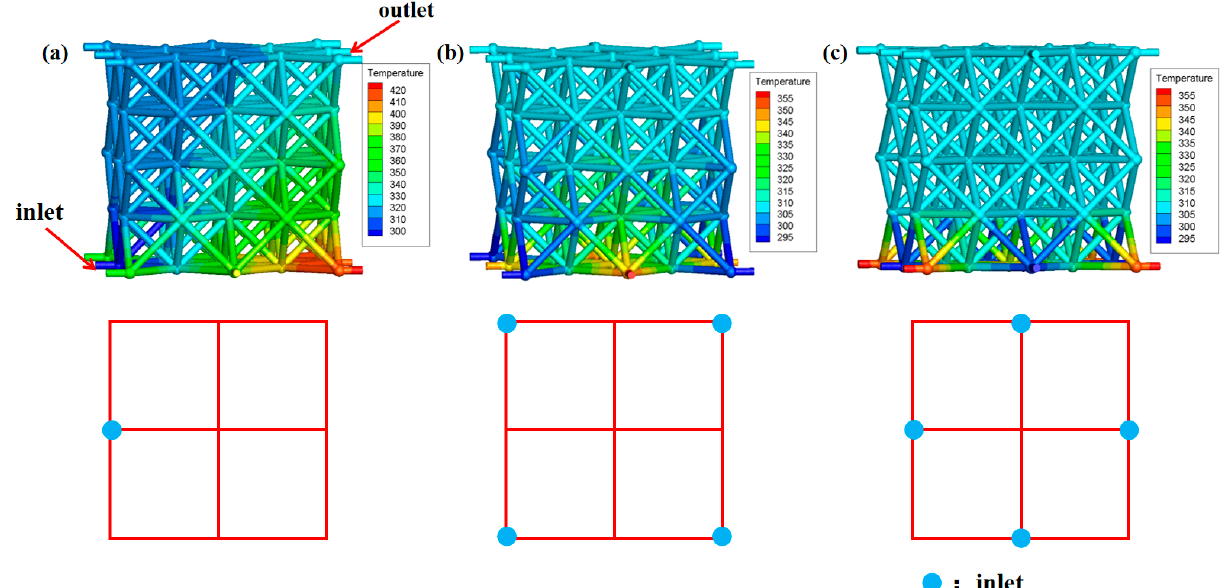
Figure 9. Influence of liquid inlet locations ( a ) one inlet in the middle; ( b ) four inlets at the corner; and ( c ) four inlets in the middle on heat dissipation performance.